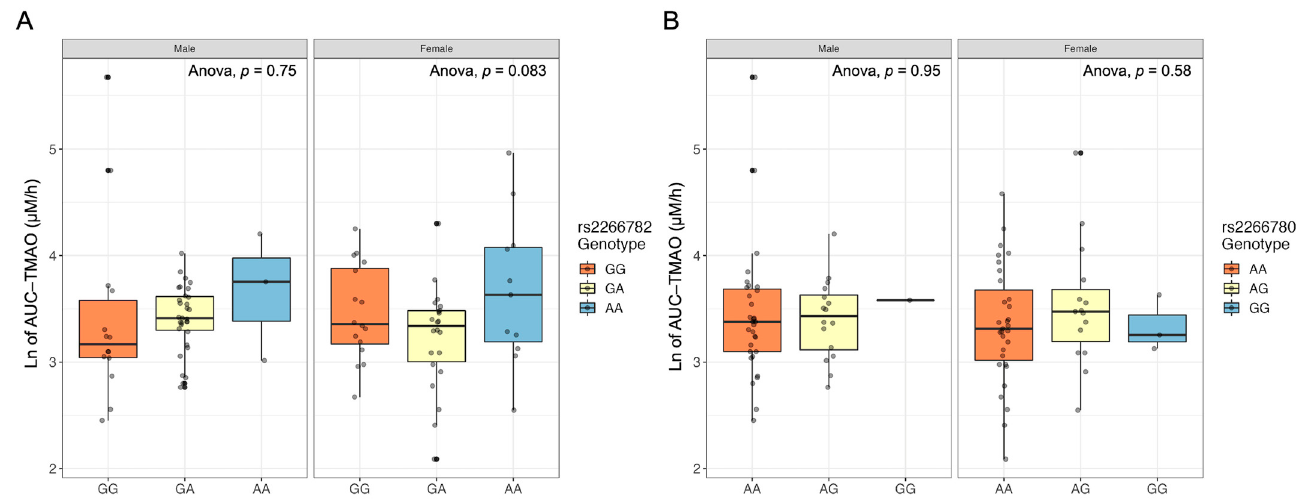
Figure 4. Relationship between postprandial TMAO exposure by genotype and sex. Relationship between AUC-TMAO (µM/h) by genotype at two FMO3 SNPs subset by sex. ( A ) Relationship between genotype at SNP rs2266782 (G>A) and AUC-TMAO. ( B ) Relationship between genotype at SNP rs2266780 (A>G) and AUC-TMAO. p -values were calculated using ANOVA.